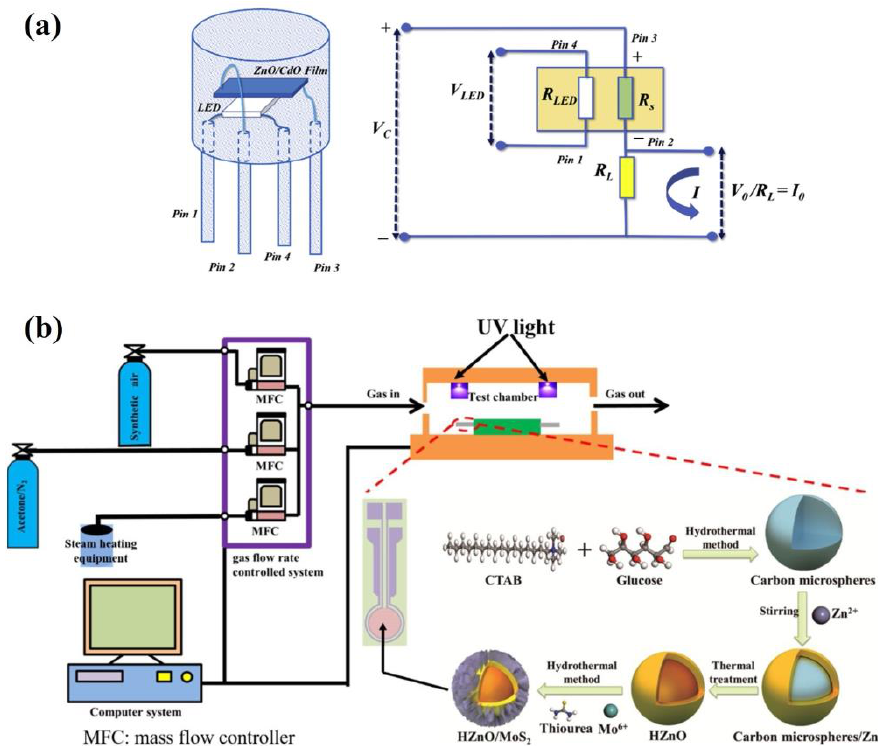
Figure 8. Diagram of ( a ) ZnO/CdO heterostructure sensor device and equivalent circuit (adapted from [60]); ( b ) gas-sensing test system and fabrication processes of HZnO/MoS 2 core–shell heterogeneous structures (adapted from [61]).